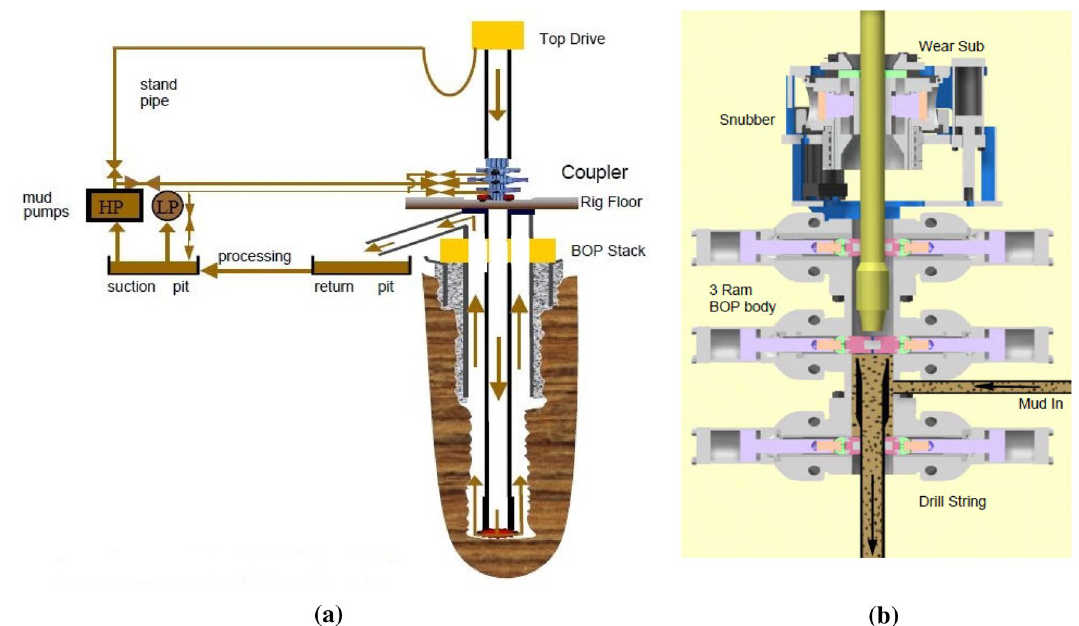
Fig. 16 a Mud flow circuit using a coupler installed at the rig floor and b cross-section of the coupler (Ayling et al.